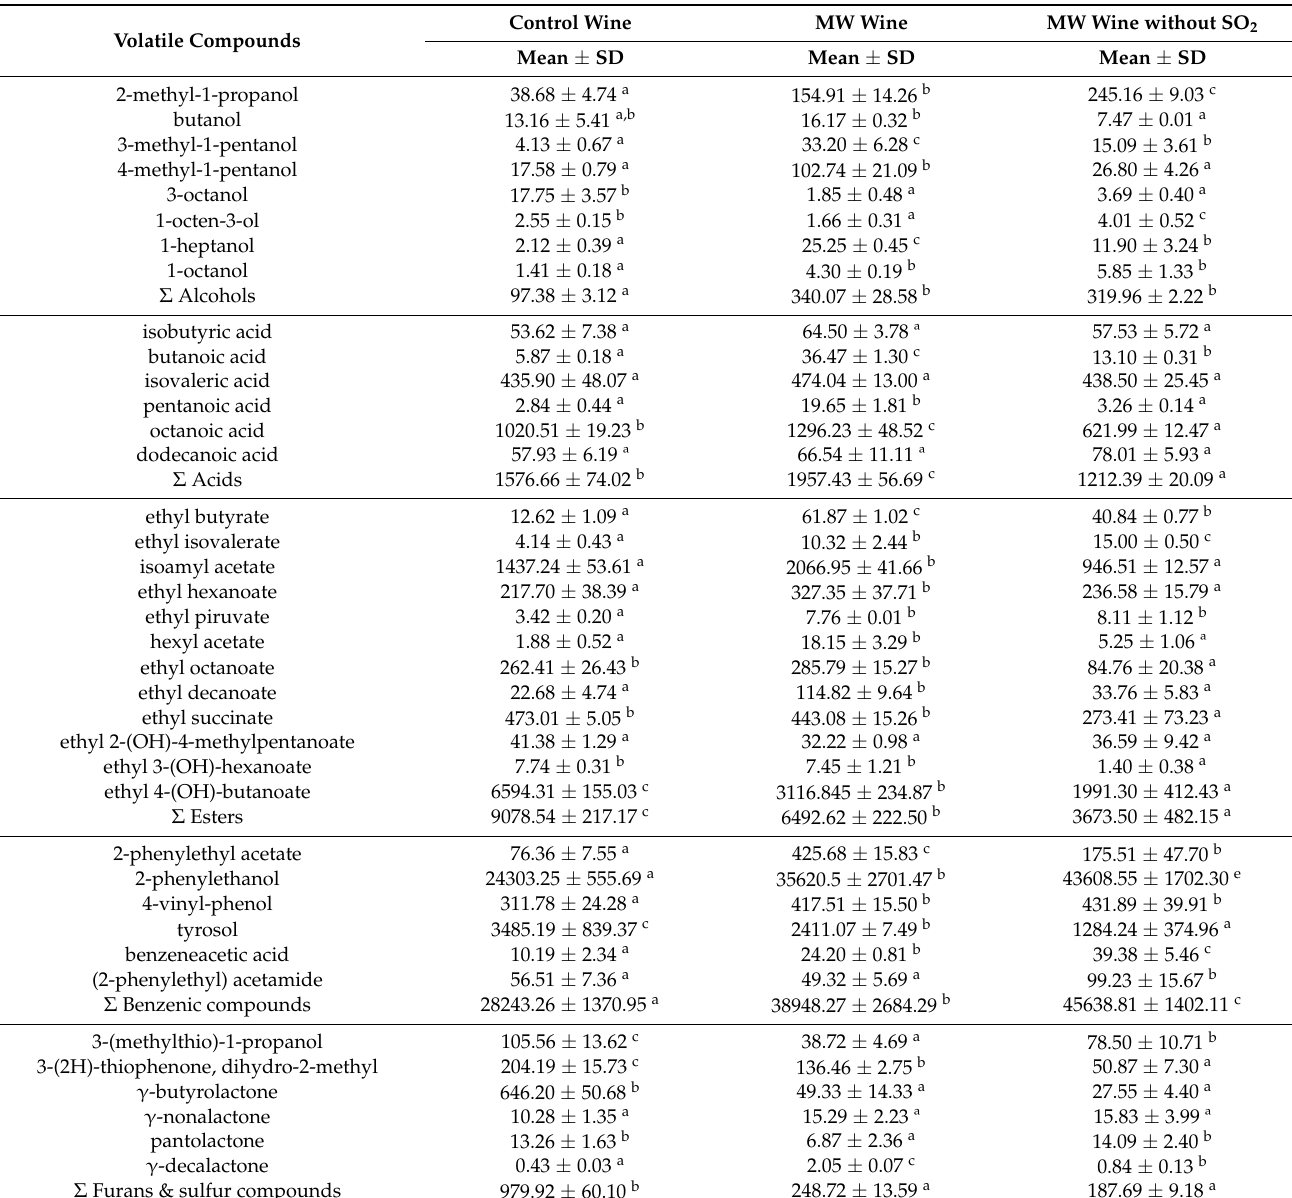
Table 3. Fermentative volatile compound concentration ( µ g/L) in control wines and those obtained from microwave-treated grapes and elaborated with and without SO 2 ( n =